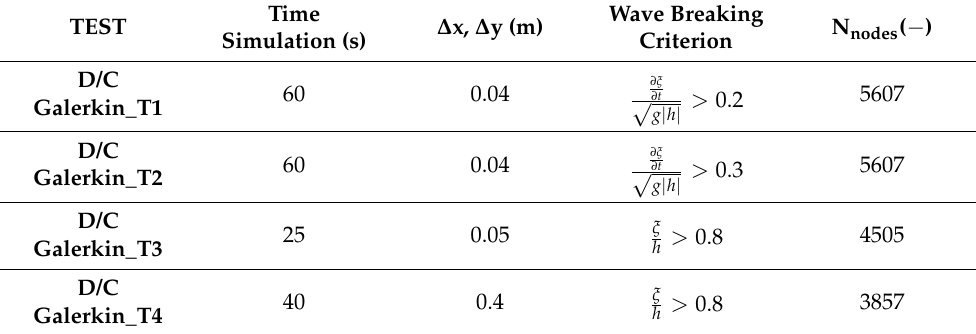
Table 3. Main characteristics of the non-hydrostatic D/C Galerkin